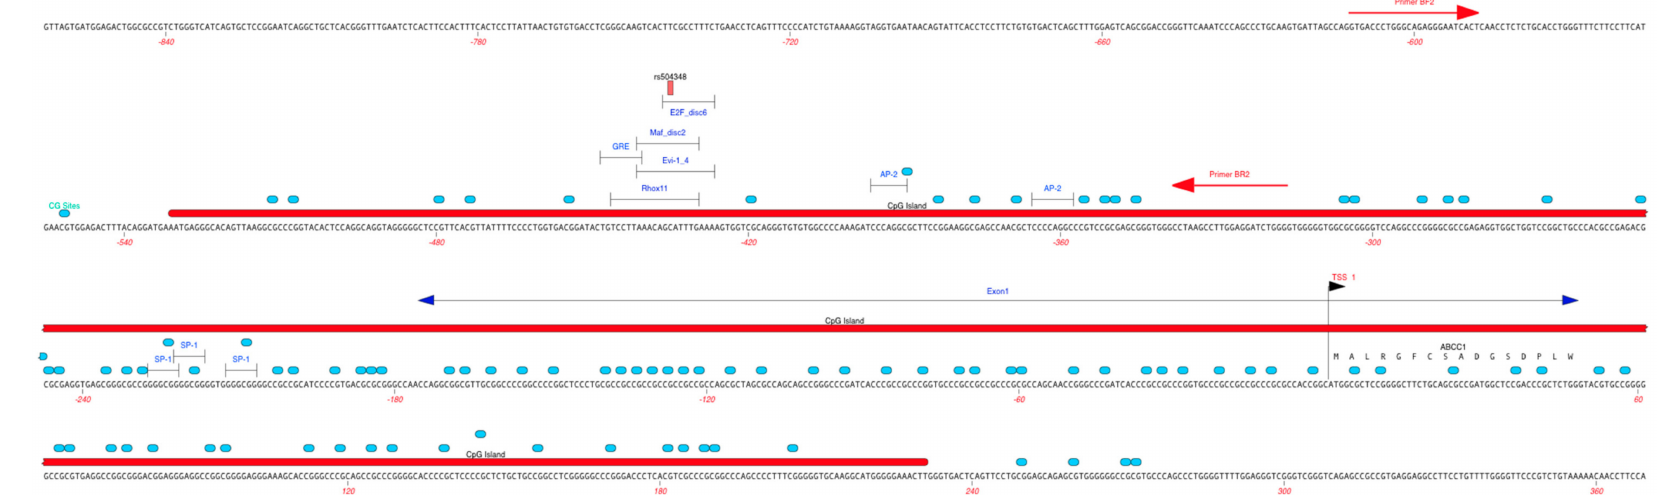
Figure 2. Annotation of the ABCC1 promoter region targeted for methylation analysis. Red line, CpG island spanning − 531 to +231 bp. BF2 and BR2 primers targeting CpG sites (blue circles) and regulatory factors (delimited lines), including the rs504348 ( − 435 bp) SNP were used for bisulfite